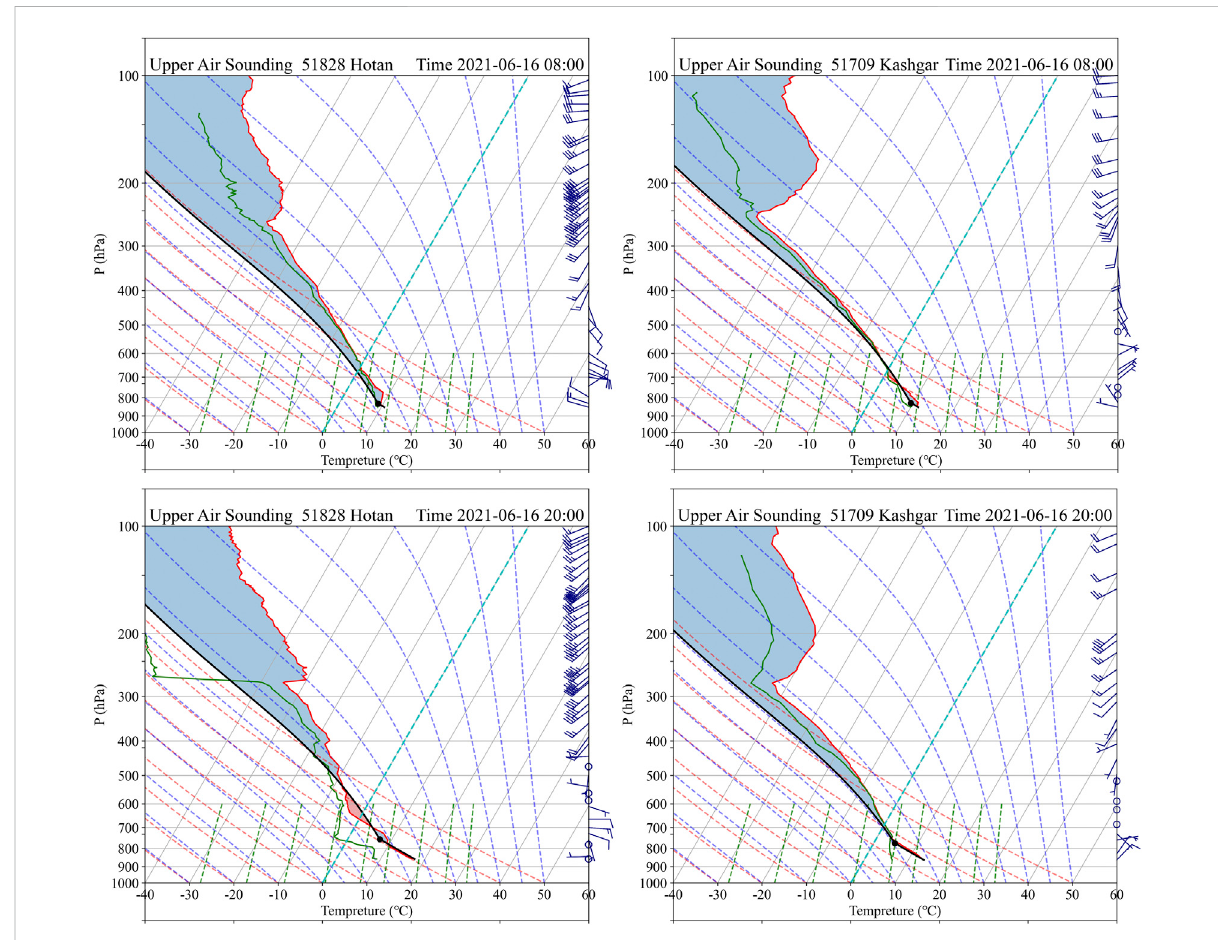
FIGURE 7 The T-lnP diagrams at 08:00 and 22:00 for the sounding stations at (A,C) Hotan (ID 51828) and (B,D) Kashgar (ID 51709) on 16 June 2021. The dark blacksolidlinesindicate statepro fi les. Thered solidlinesaretemperaturestrati fi cationpro fi les. Thegreensolidlinesare dewpointstrati fi cation pro fi les. The blue dashed lines arewet adiabatic pro fi les. The orange dashed linesare dry adiabatic pro fi les. The green dashed lines are iso-saturated speci fi c humidity pro fi les. The gray sloping solid lines are isothermal pro fi